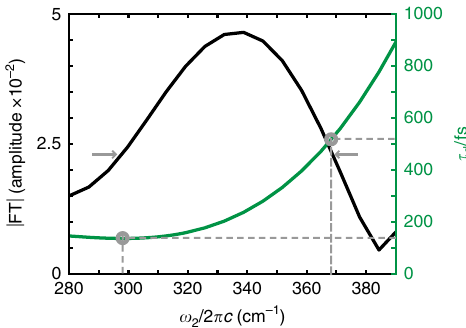
Fig. 4 Early MLCT relaxation dynamics: electronically localized excited- state vibrational wave packet. The ω 2 spectral amplitude (black; FWHM = gray arrows) of the MLCT B excited-state vibrational wave packet arises due to coherence between the ν COO and one quantum of a Ru-N stretching mode ( ν Ru-N = 340 cm − 1 ) within the excited-state manifold. The τ d - dependence of the ω 2 frequencies composing the wave packet (green) indicate blue-shifting as the wave packet propagates. Although the analytical form of τ d ( ω 2 ) depends heavily on the polynomial function used to fi t ϕ ( ω 2 ), the blue-shifting behavior of the wave packet is consistent across many functions. See Supplementary Note 4, Supplementary Fig. 8, and Supplementary Table 3 for spectral phase fi the ν Ru-bpy mode (see Supplementary Note 6 and Supplementary